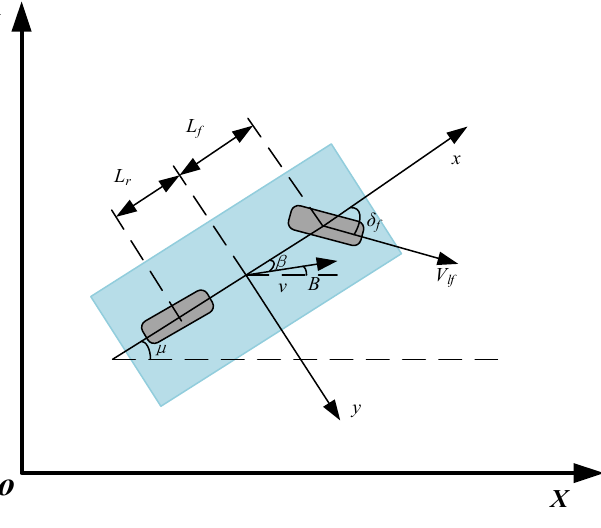
Figure 3. Vehicle kinematics model.